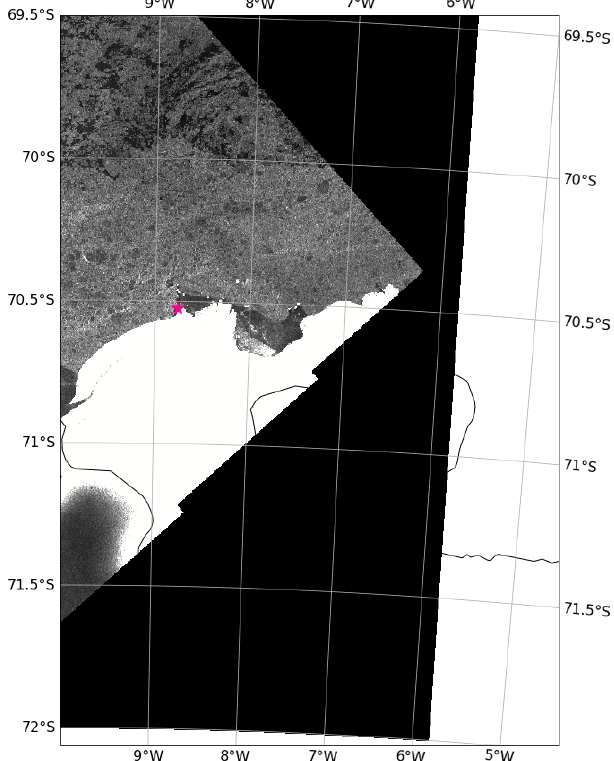
Figure A1. Sentinel-1 SAR image of the Ekström Ice Shelf and polynya on 12 January 2015 (PS89) (ESA, 2021). The pink star indicates the sampling location for the PS89 tidal